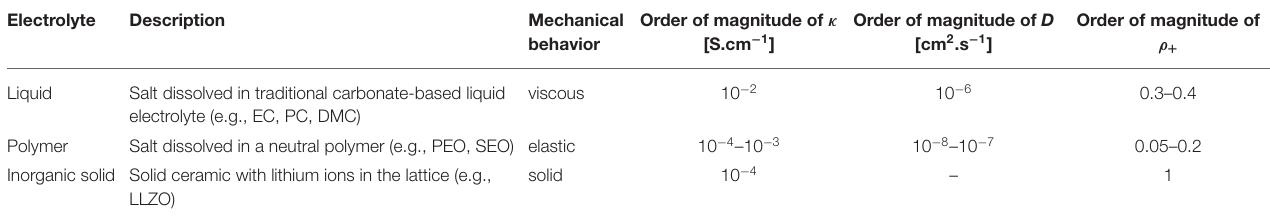
TABLE 3 | The three categories of electrolytes covered in this review, with their description, order of magnitude of ionic conductivity, κ , order of magnitude of the salt diffusion coefficient, D , characteristic range of steady-state current fraction, ρ + , and characteristic mechanical behavior at the temperature of interest.